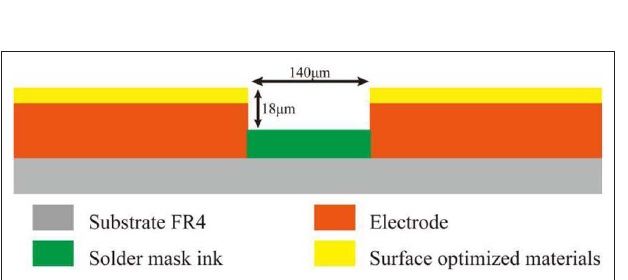
FIGURE 7 | Schematic diagram of two adjacent electrodes on a PCB-based EWOD.